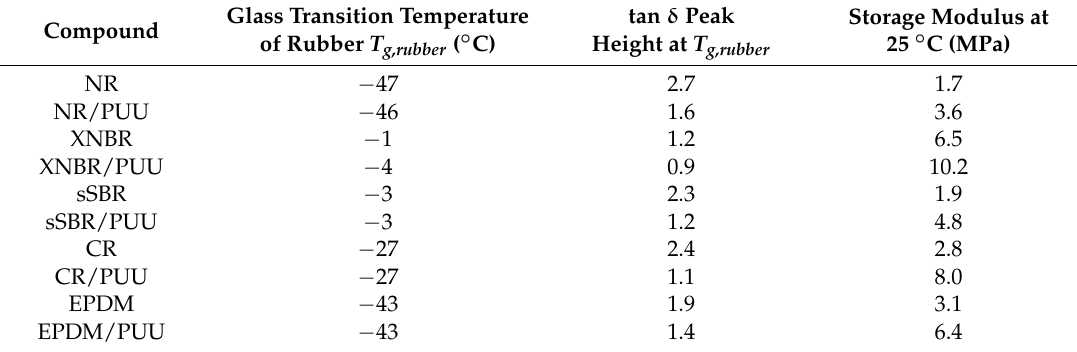
Table 3. Dynamic-mechanical characteristics of neat rubbers and their rubber/PUU